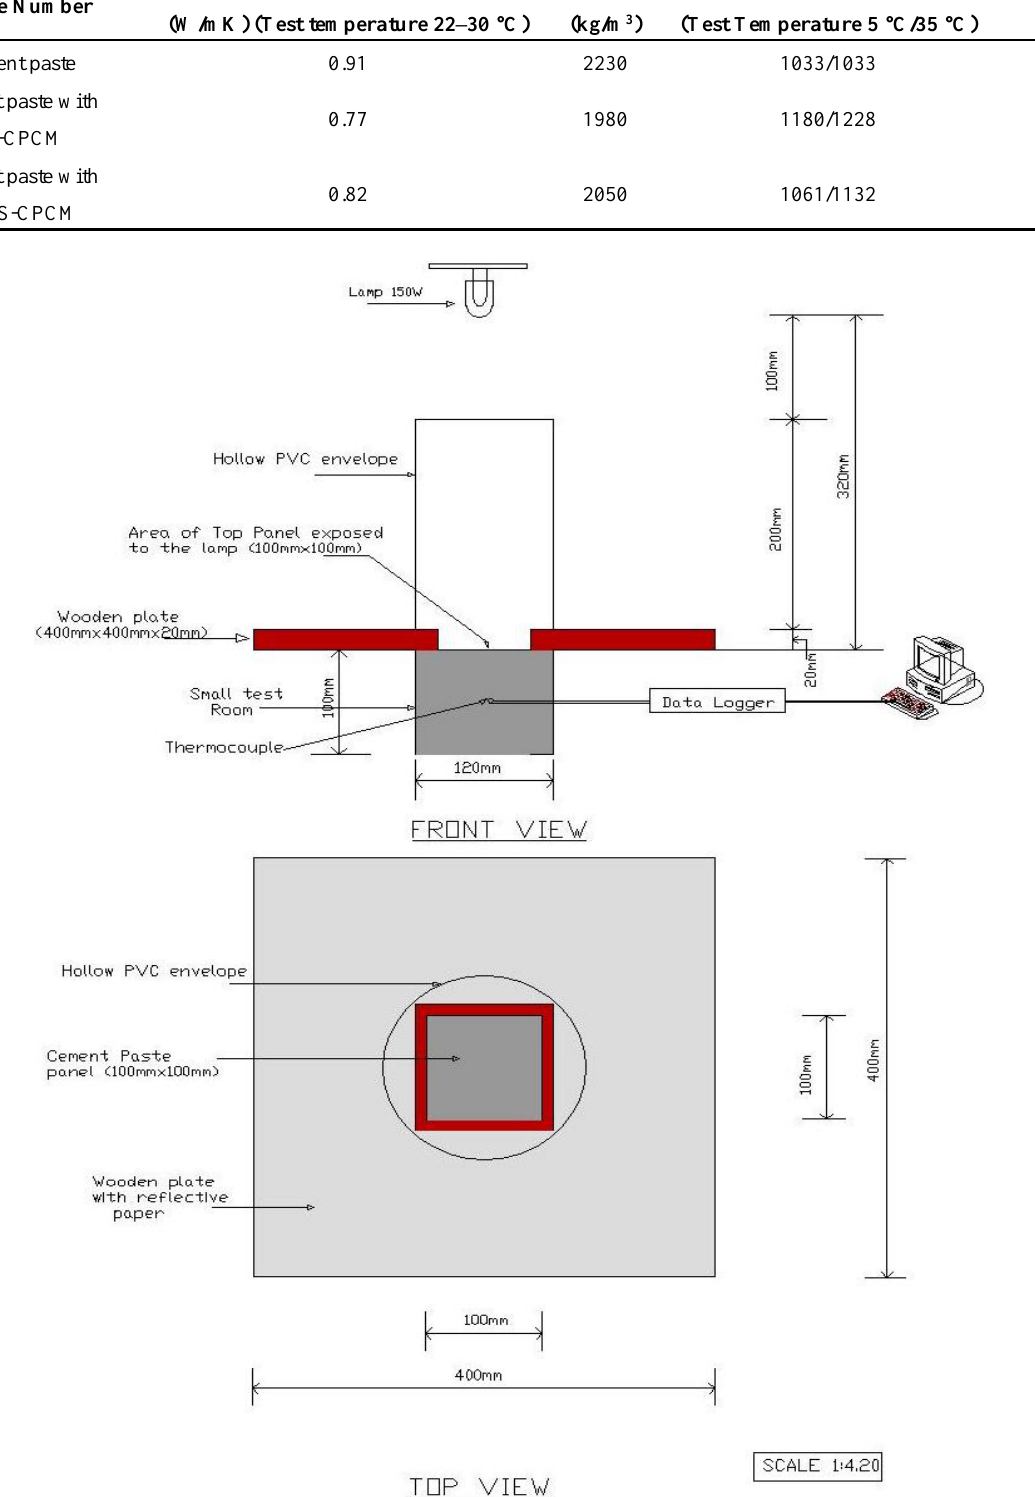
Table 2. Physical characteristics of the materials used.